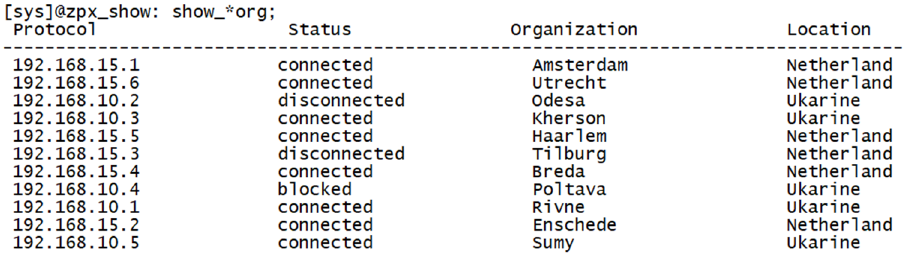
Figure 8. Details of all organizations.